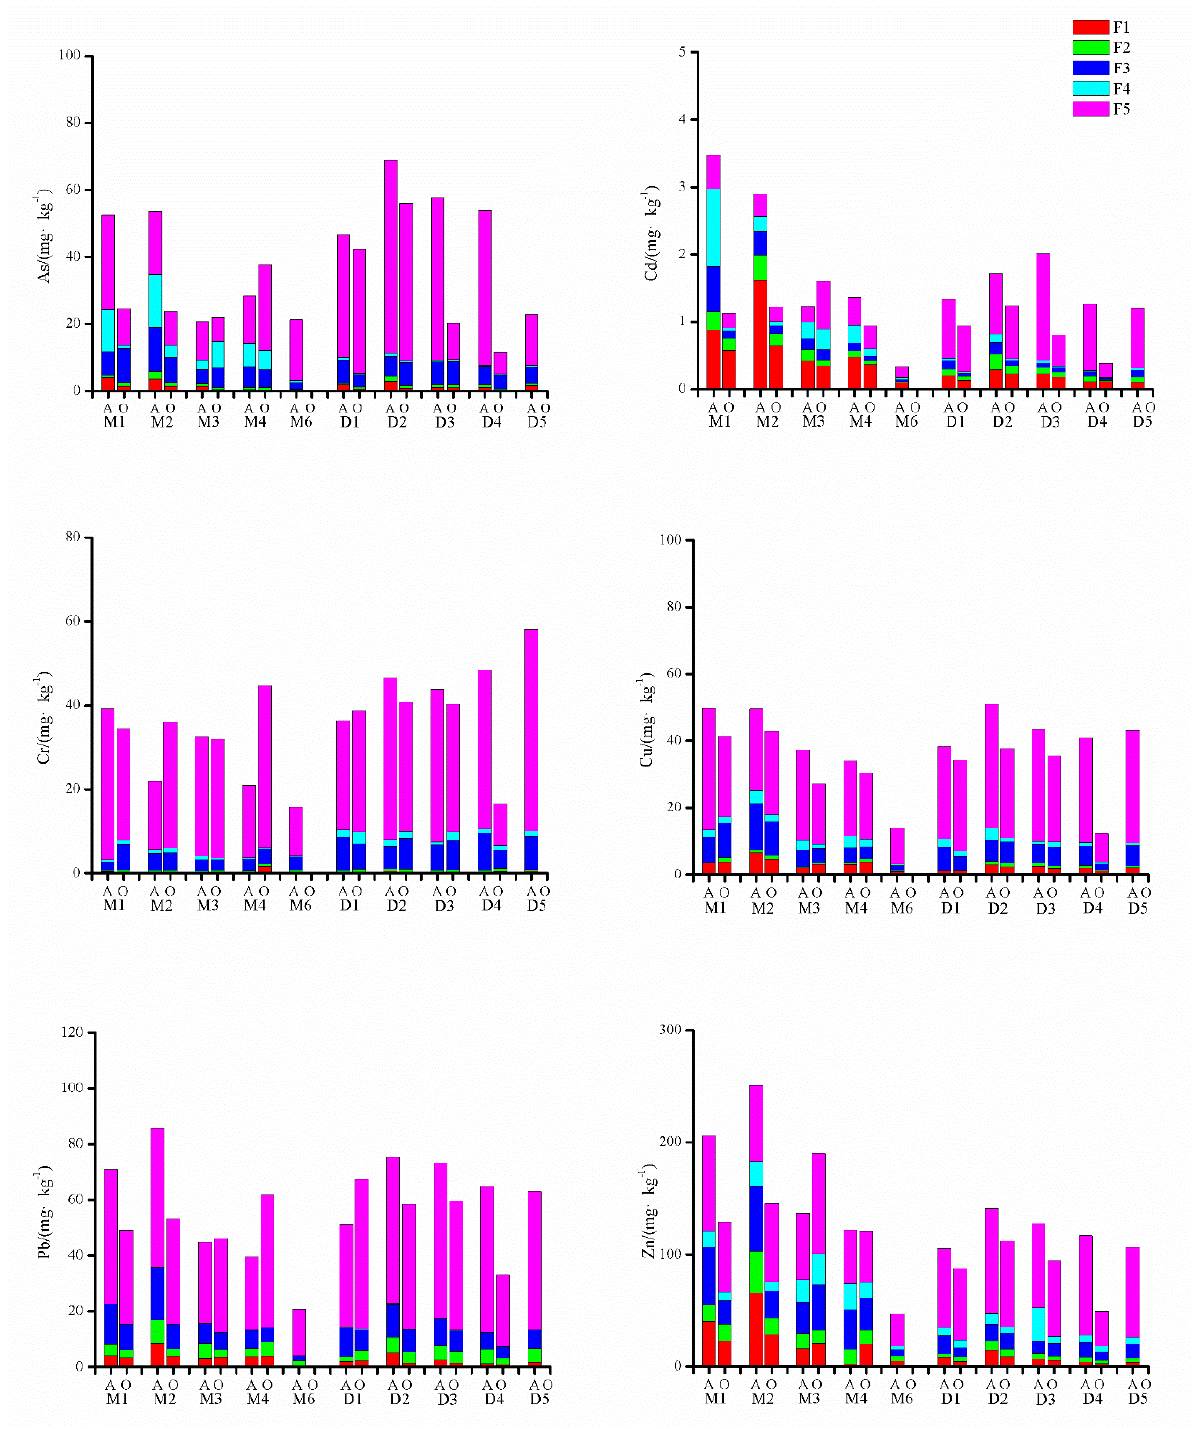
Figure 3. Speciation of heavy metal in surface sediments of Manwan (M) and Dachaoshan (D) cascading dams. A = Dry season, April 2016. O = rainy season, October 2016; F1 = exchangeable and carbonate bound; F2 = Fe/Mn oxide bound; F3 = organic substance bound; F4 = sulfide bound; F5 = residual; total = total concentration of heavy metals.